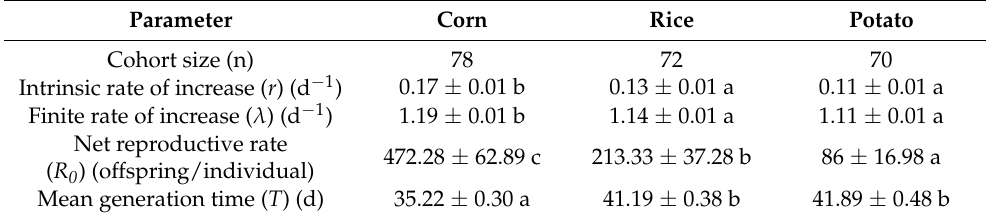
Table 2. The values of the intrinsic rate of increase ( r ) (0.17 per day), finite rate of increase ( λ ) (1.19 per day), net reproductive rate ( R 0 ) (472.28 offspring per individual) were significantly ( p < 0.0001) higher on corn than on rice and potato. The mean generation time ( T ) was significantly ( p < 0.0001) lower on corn plants (35.22 days) compared to rice (41.19 days) and potato (41.89 days). Table 2. Population parameter of Spodoptera frugiperda fed on corn, potato, or rice plants.